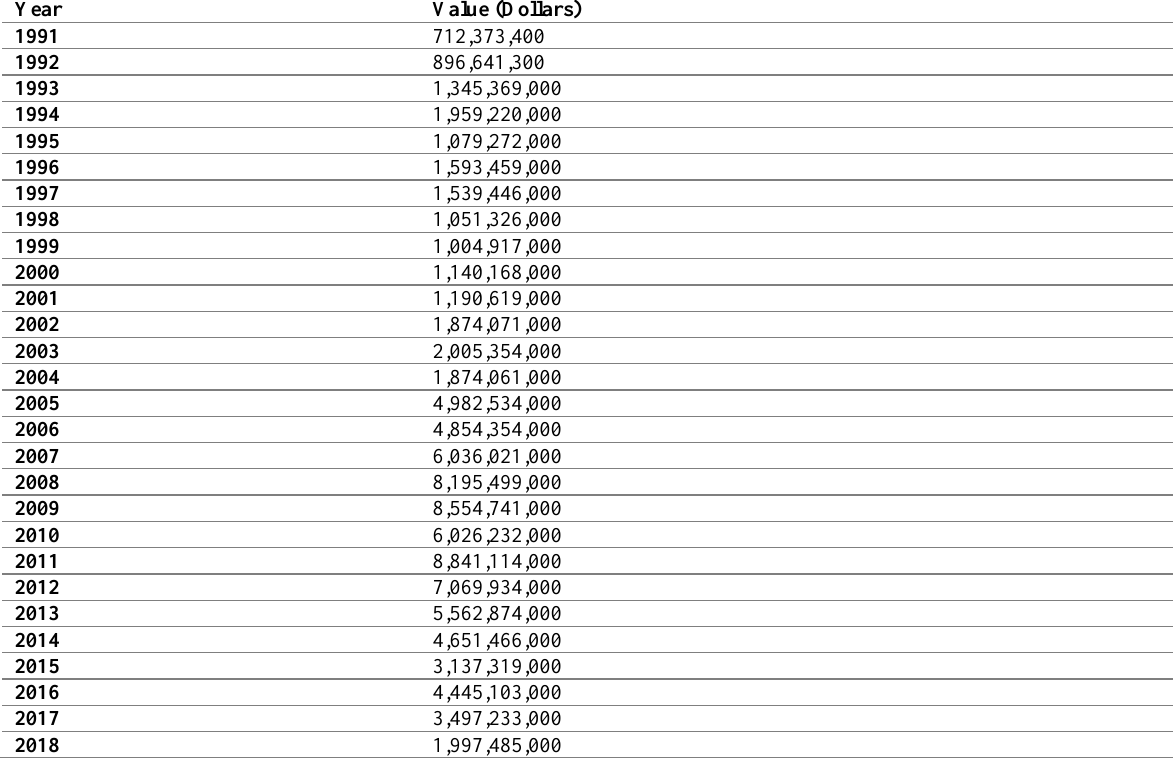
Table 2: FDI inflow to